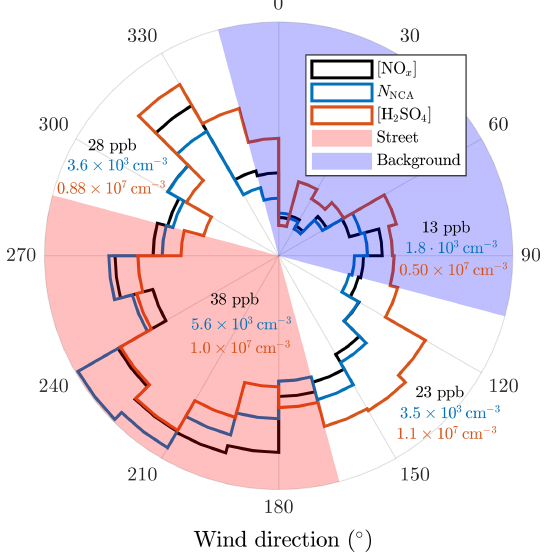
Figure 9. The 10min averages of the NO x , NCA, and H 2 SO 4 concentrations further averaged to different wind direction sectors. Wind velocities smaller than 0.5ms − 1 are excluded. The geometric averages of the concentrations across the sectors are shown in the